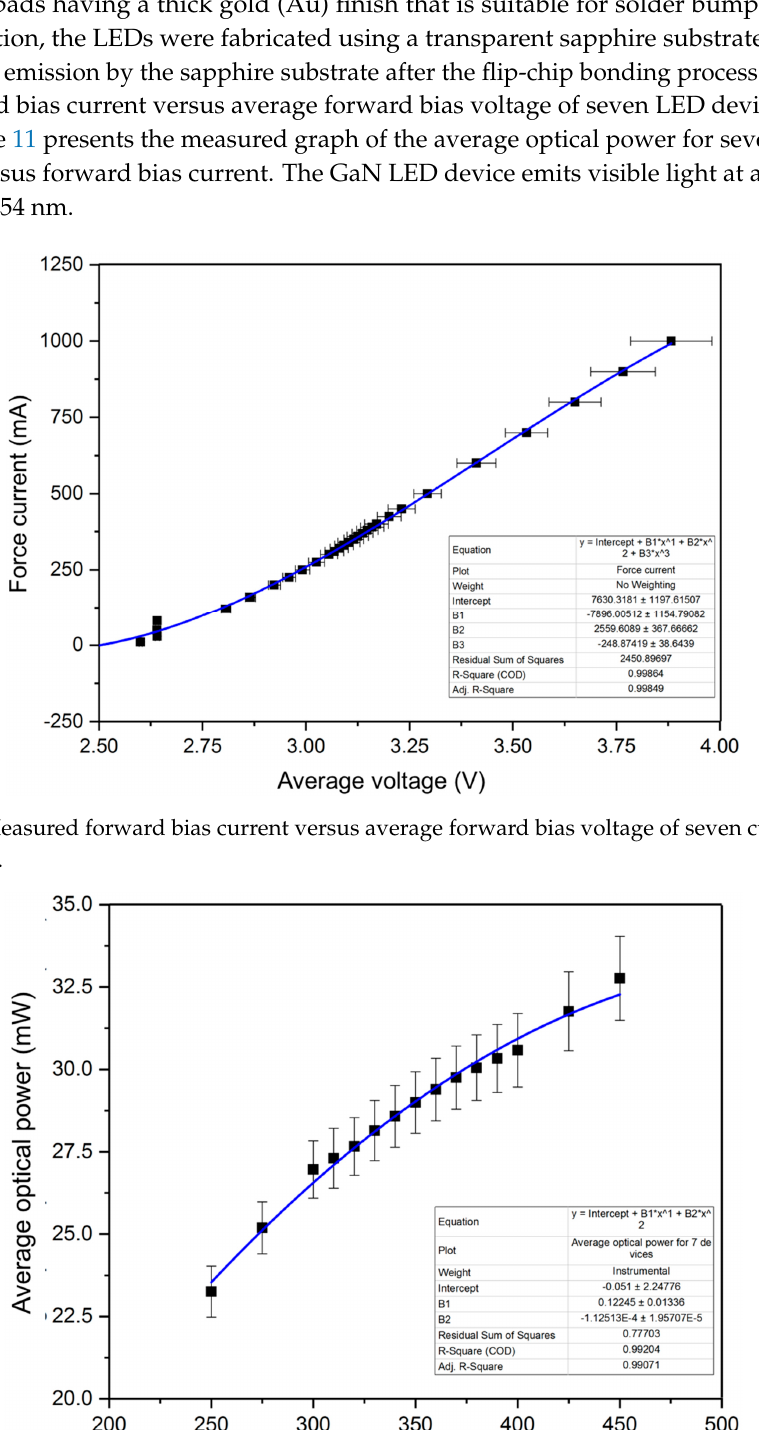
Figure 9. EPC2036 in passivated die form with solder bumps.